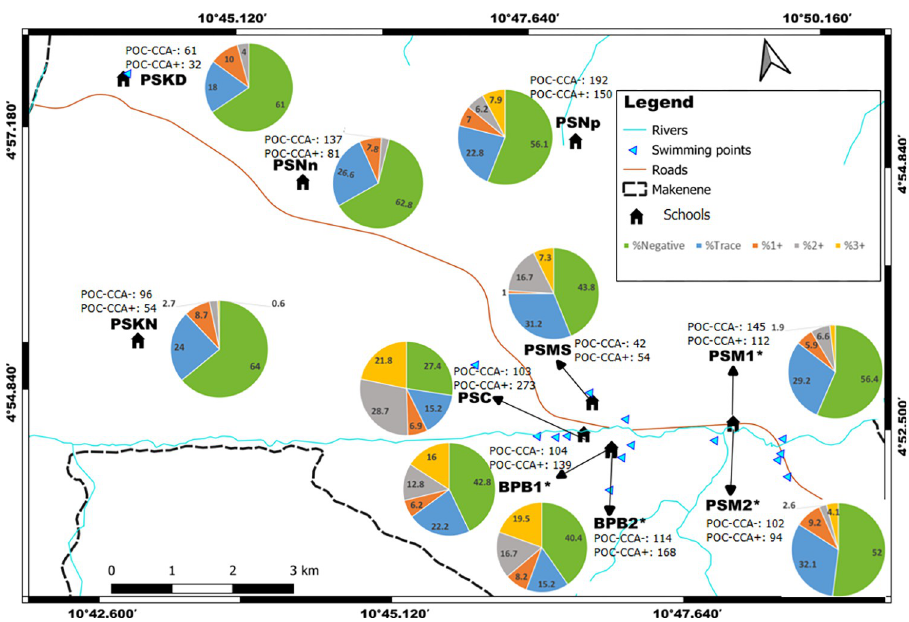
Fig 5. Distribution per school of the percentage of children with no infection or carrying different infection intensities inferred from POC-CCA (base layer of the maps were obtained using a free online spatial data software (https://www. diva-gis.org/gdata). BPB1: Government bilingual primary school of Baloua group 1; BPB2: Government bilingual primary school of Baloua group 2; PSM1: Public school of Makenene group 1; PSM2: Public school of Makenene group 2; PSNn: Public school of Nyokon; PSKD: Public school of Kinding Nde; PSKN: Public school of Kinding Ndjabi; PSMS: Public school of Mock-Sud; PSC: Public school of Carri è re; PSNp: Public school of Ngokop, � : Schools in the same building. POC-CCA+: Number of children positive to POC-CCA in each school; POC-CCA-: Number of children with negative POC-CCA in each school.